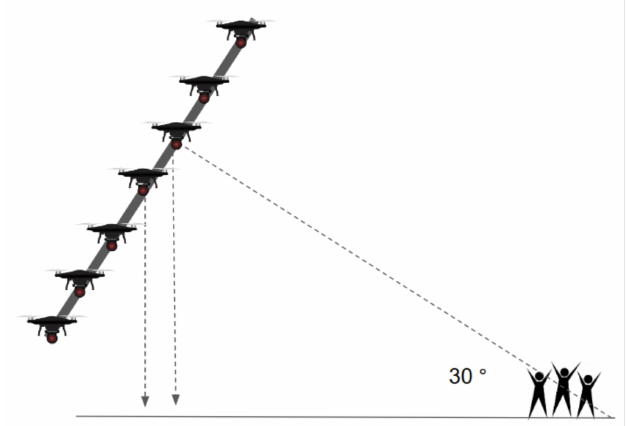
Figure 11. Proposed scene representation method.